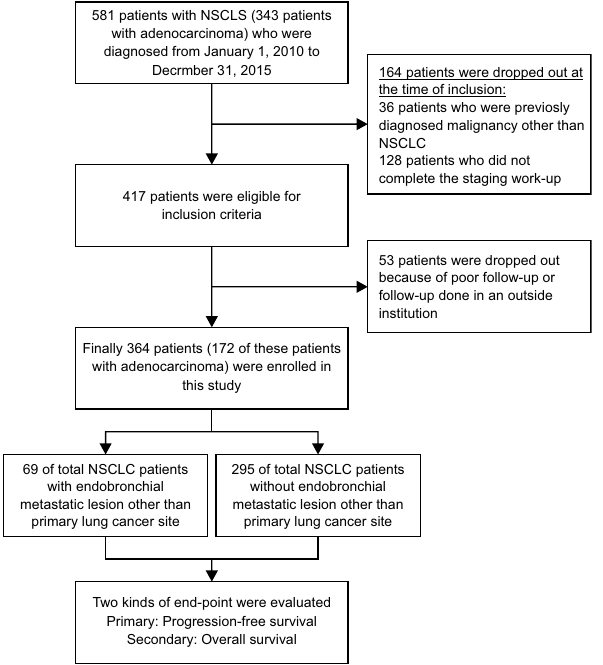
Figure 1. Flowchart for enrolled patients Flowchart illustrates selection process for patients with NSCLC who were diagnosed during the study period. NSCLC non-small cell lung cancer, PET/CT positron emission tomography/computed